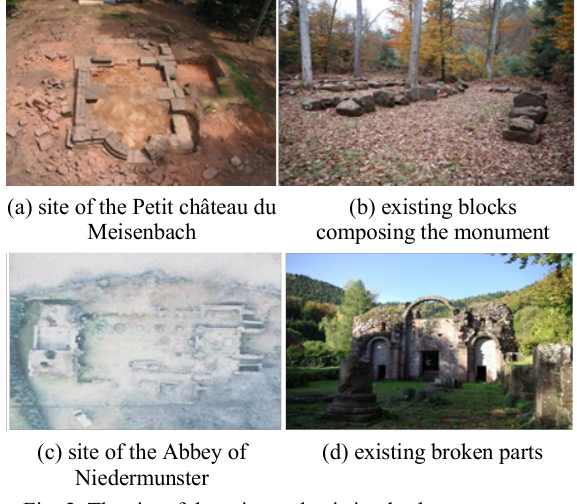
Fig. 2. The site of the ruins and existing broken